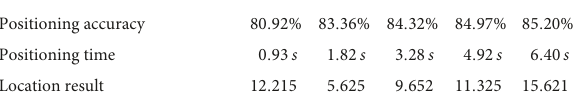
TABLE 2 The simulation results of the size of the positioning region based on the k-nearest neighbor